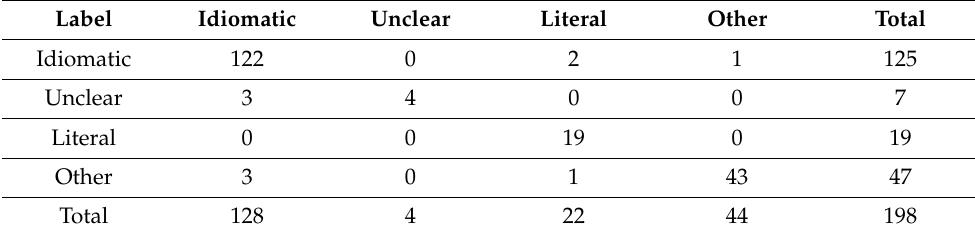
Table 3. Confusion matrix on the double-annotated